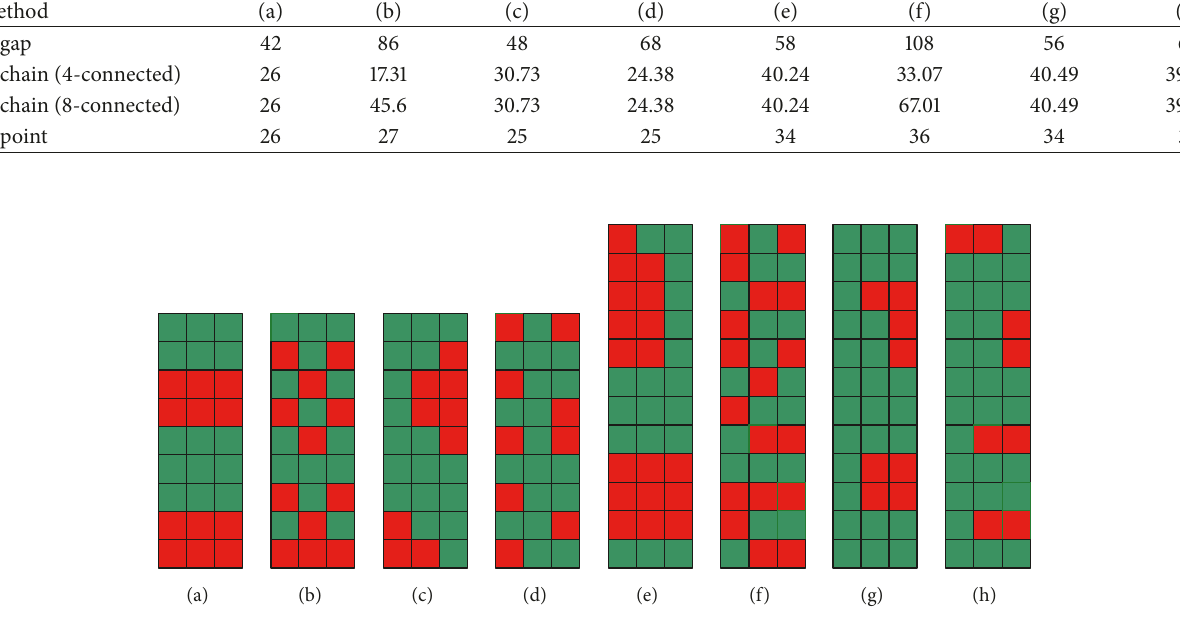
Figure 1: Special cases subpixel